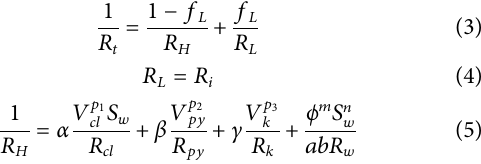
Frontiers in Earth Science |